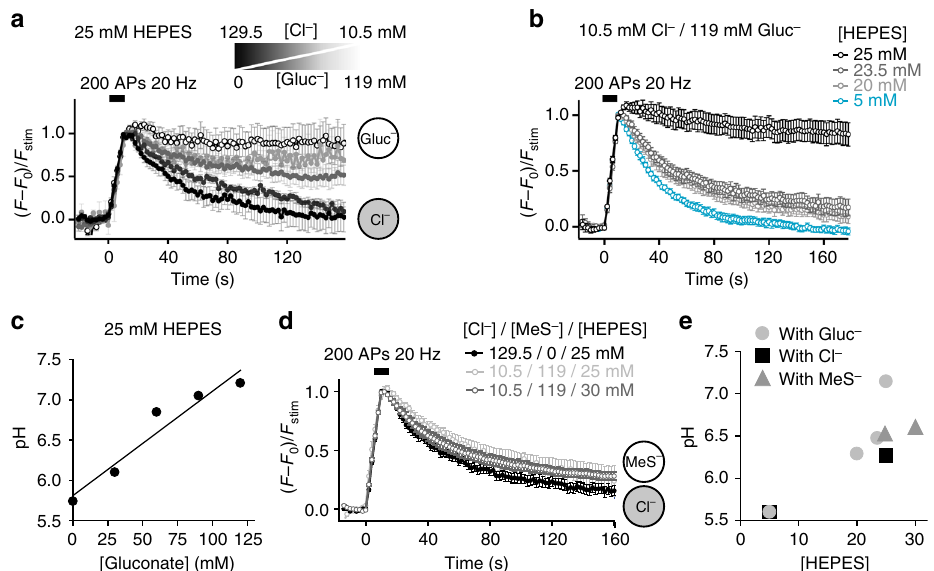
Fig. 5 Dependence of SV acidi fi cation on luminal buffering capacity. a Average SpH transients in response to stimulation (200 APs, 20 Hz) in neurons exposed to different combinations of extracellular chloride/gluconate concentrations ([Cl − ]/[Gluc − ]) ( n = 3 – 10). Cl − concentration is decreased from 129.5 mM (black) to 100 – 70 – 40 – 10.5 mM while being substituted by Gluc − to maintain a fi nal anion concentration of 129.5 mM. The sketches show the main anion present in SV. b Average SpH fl uorescence responses to 200 APs at 20 Hz in presence of 10.5 mM Cl − , 119mM Gluc − and different HEPES concentrations as indicated ( n = 6 – 14). c Luminal pH of SVs endocytosed with various Gluc − concentrations, estimated from the plateaus reached in a . d Average SpH responses to stimulation (200 APs, 20 Hz) in neurons exposed to different HEPES concentrations and different combinations of extracellular chloride/methanesulfonate concentrations ([Cl − ]/[MeS − ]) ( n = 7 – 16). The sketches show the main anion present in SV. e Luminal pH of SVs endocytosed with various HEPES and ion concentrations, estimated from the plateaus reached in a , b , d . Traces in a , b , d represent responses of glutamatergic boutons only. Error bars represent